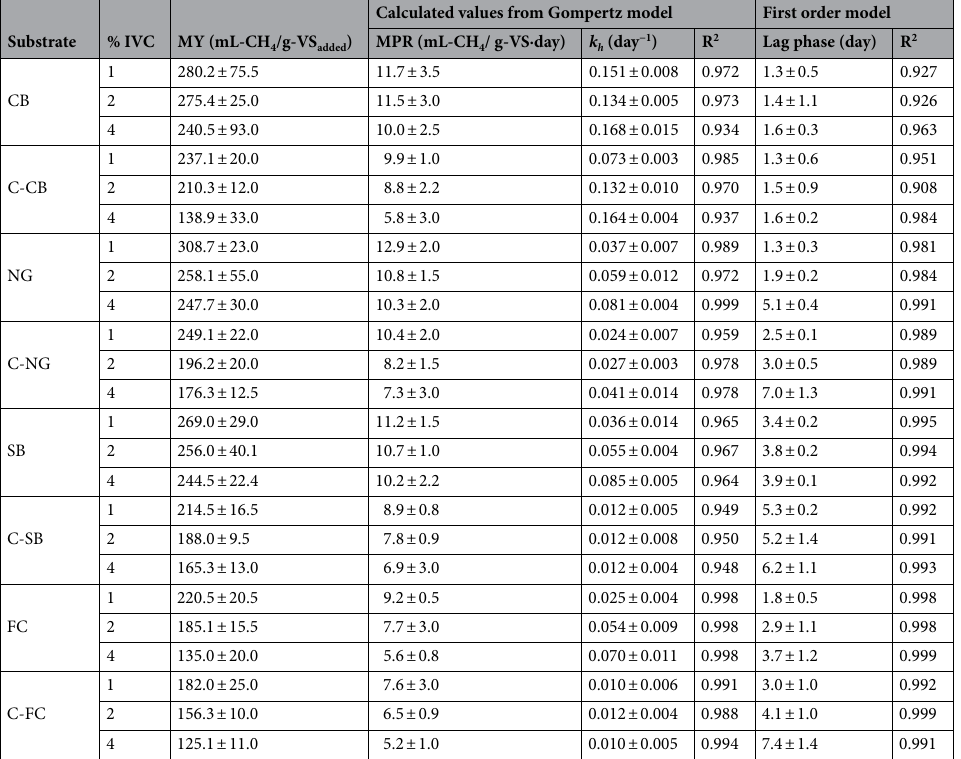
Table 6. Methane production of lignocellulosic material augmentation with 10%v/v KKU-MC1, and non- augmentation (control: